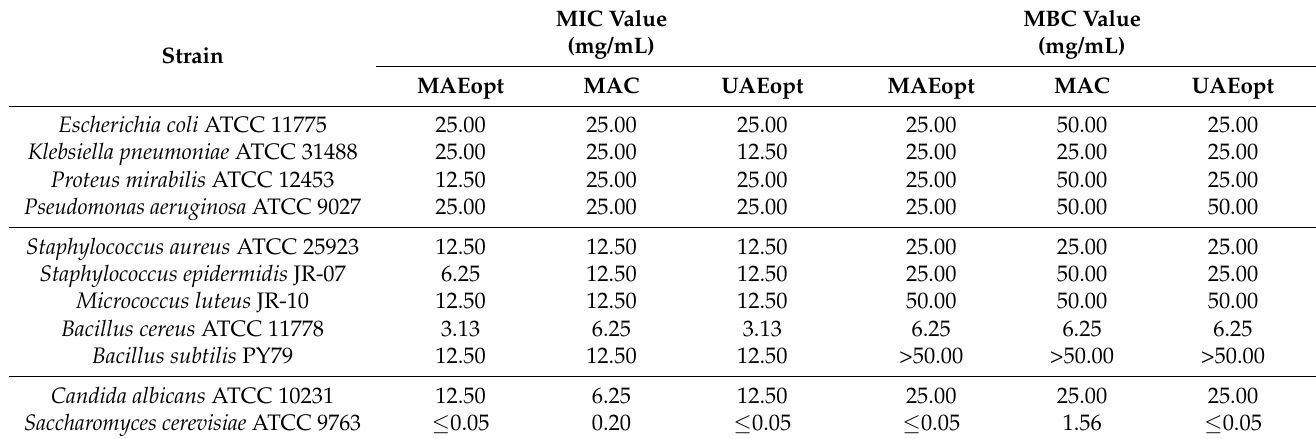
Table 6. Antimicrobial activity (MIC and MBC values) of horehound